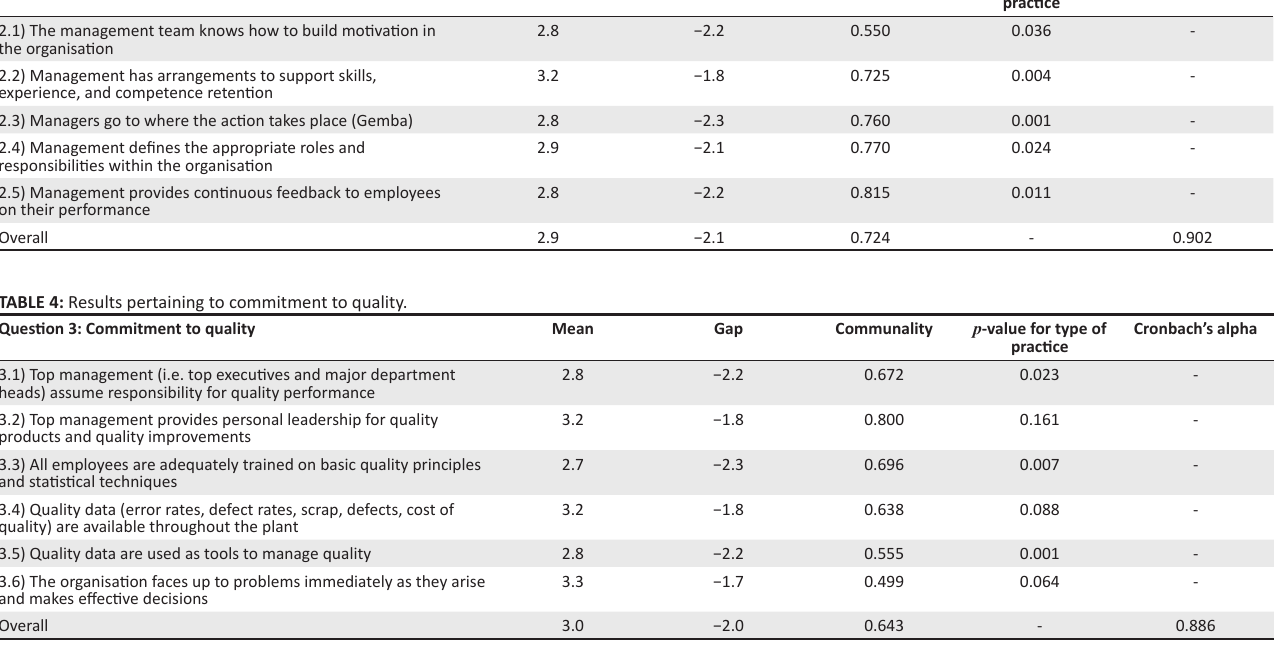
TABLE 3: Results pertaining to management commitment and leadership. Question 2: Management